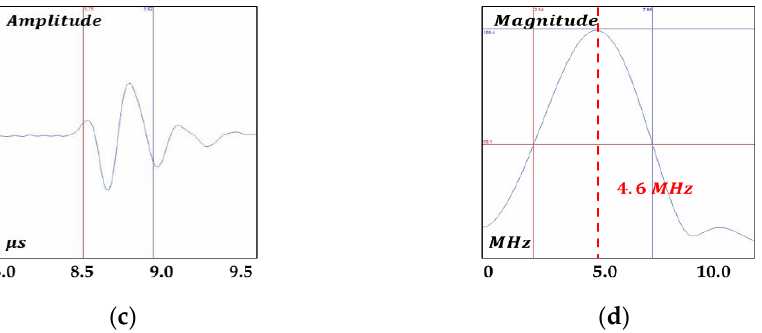
Figure 11. Results of 16th channel frequency analysis: ( a ) echo pattern of P/E type FPAPr; ( b ) fast Fourier transform (FFT) analysis results of P/E type FPAPr; ( c ) echo pattern of T/R type FPAPr; ( d ) FFT analysis results of T/R type FPAPr.